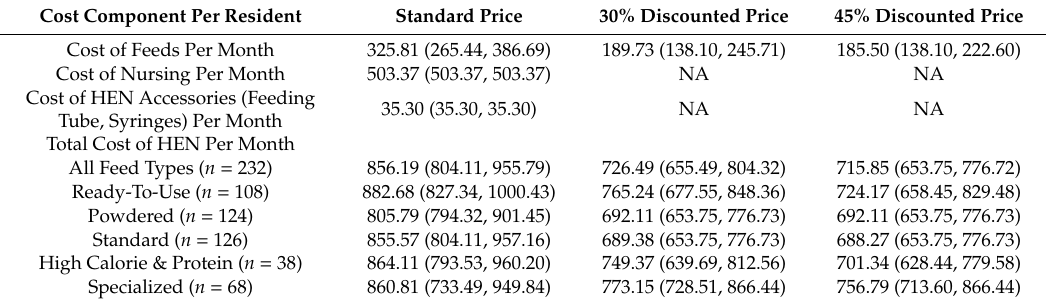
Table 4. Monthly (28-day) Cost of Full Enteral Nutrition in LTCF ( n = 232). Prices Reported in Singapore Dollars (Median with